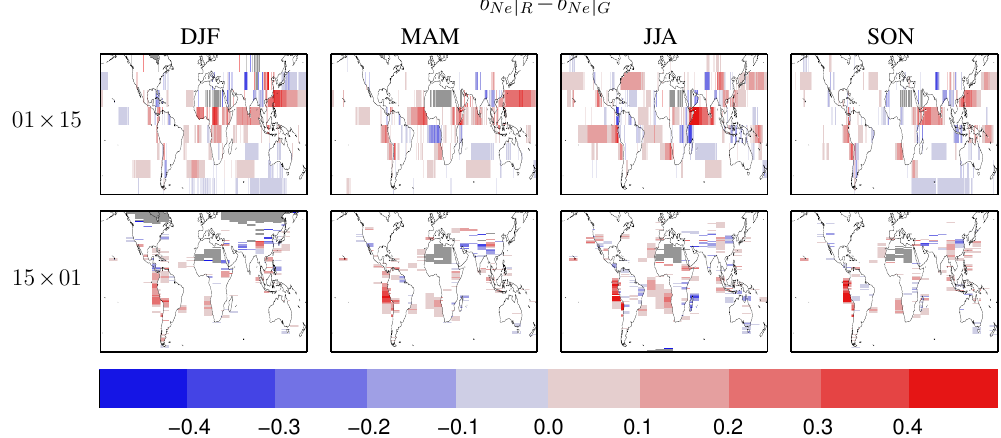
Fig. 4. Difference in sensitivity of N e to τ a between the region–method and grid–method for different seasons and two different region Fig. 3. Difference in sensitivity of N e to τ a between the region-method and grid-method for different seasons and two different region shapes shapes (meridional and zonal). White regions are where the data is not significantly different from zero at two–sigma confidence. Grey represents missing data. (meridional and zonal). White regions are where the data are not significantly different from zero at two-sigma confidence. Grey represents missing